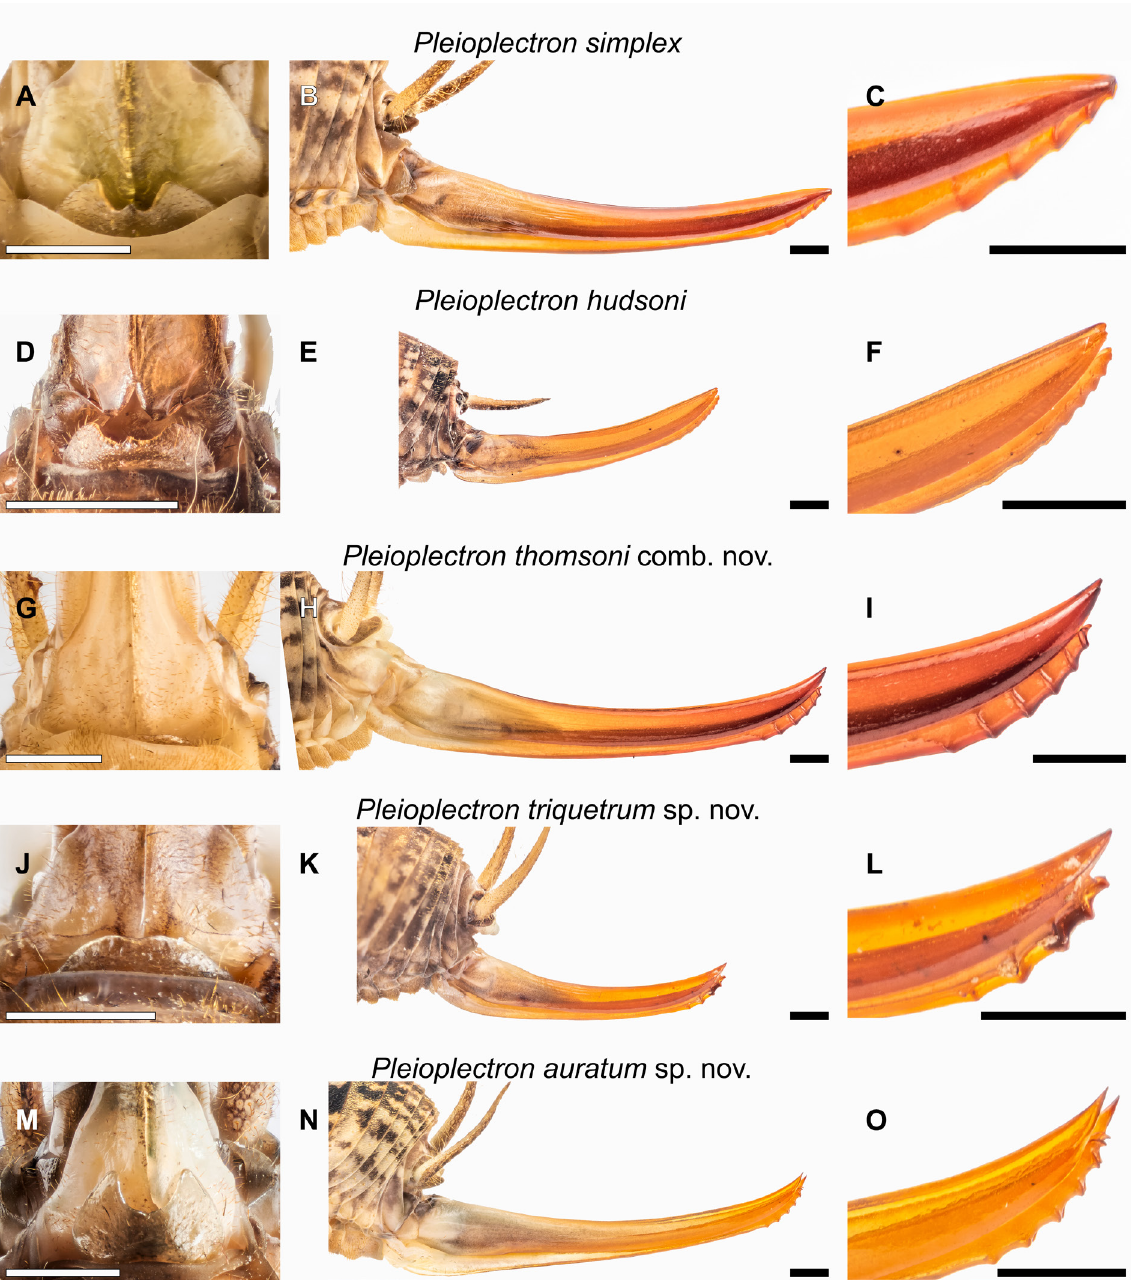
Fig. 10. Adult female terminalia of cave wētā in the genus Pleioplectron Hutton, 1896. Left column: subgenital plate; central and right columns: ovipositor. A–C . P. simplex Hutton, 1896, Hinewai